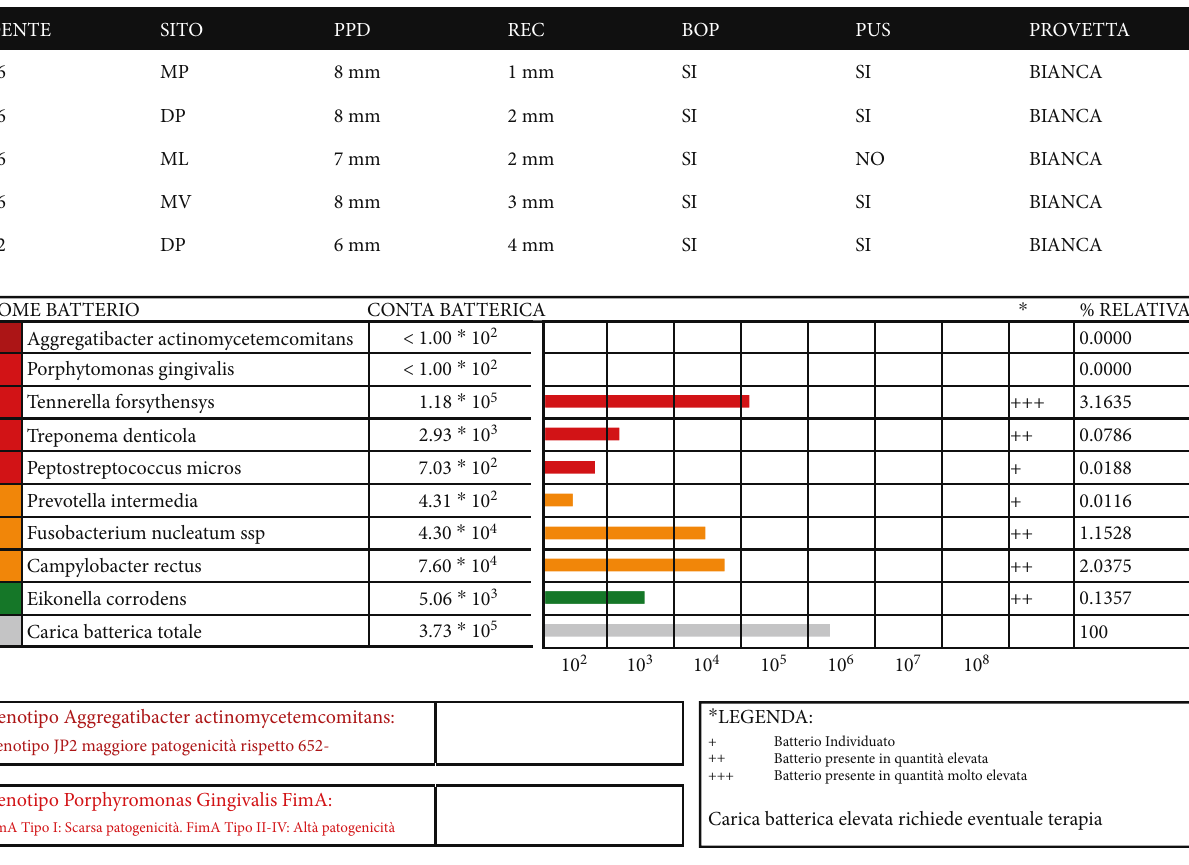
Figure 6: Microbiological test results.